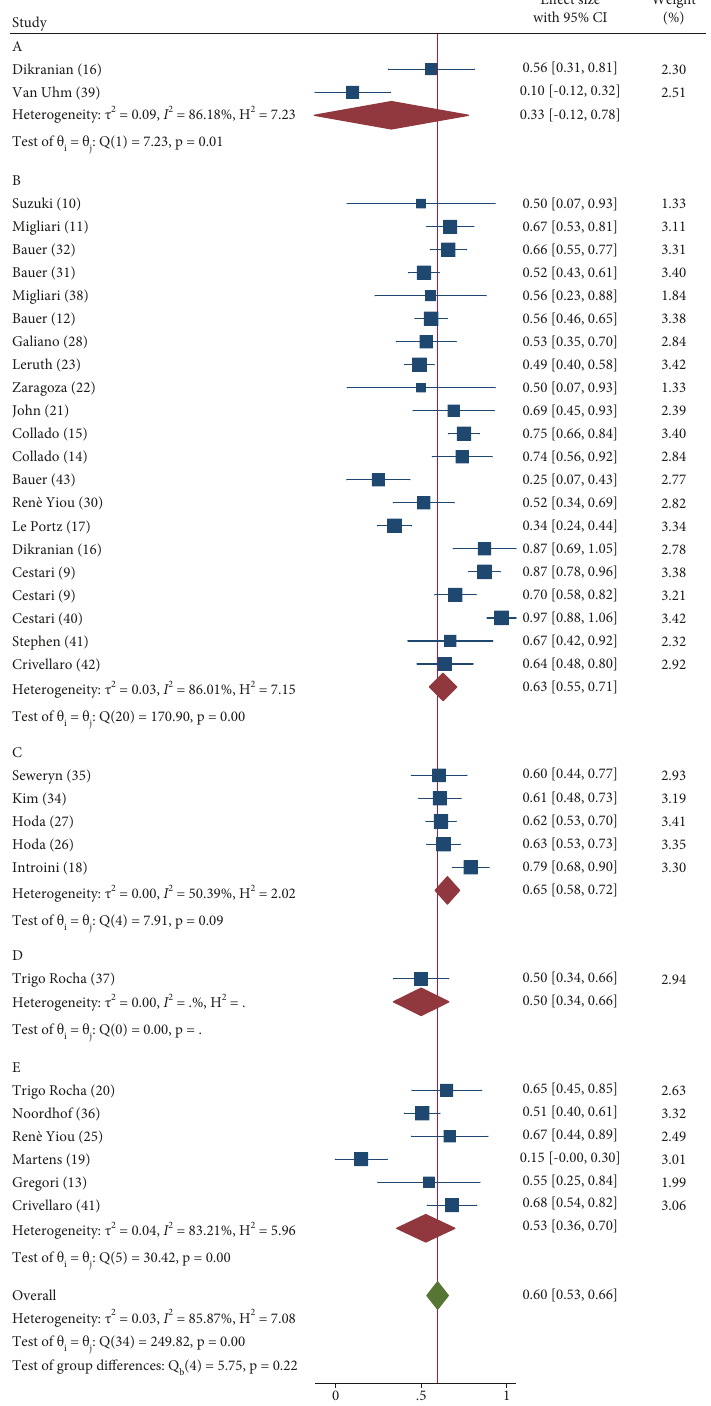
Figure 2: Forrest plot assessing pad-free event rate recovery after device placement according to the five groups of invasive treatments for UI after RP implemented within the studies included for analysis. ( A � bulking agents, B � fixed slings, C � adjustable slings, D � circumferential compressor device, and E � noncircumferential compressor devices; SD � standard deviation; CI � confidence